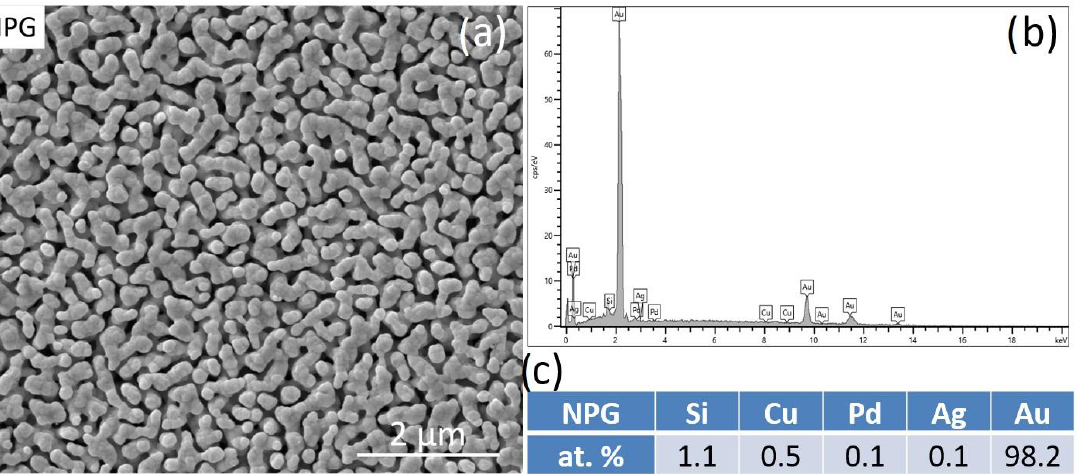
Figure 2. ( a ) SE-SEM image, ( b ) EDS spectrum and ( c ) composition in at. % of the NPG obtained by dealloying of the amorphous precursor.